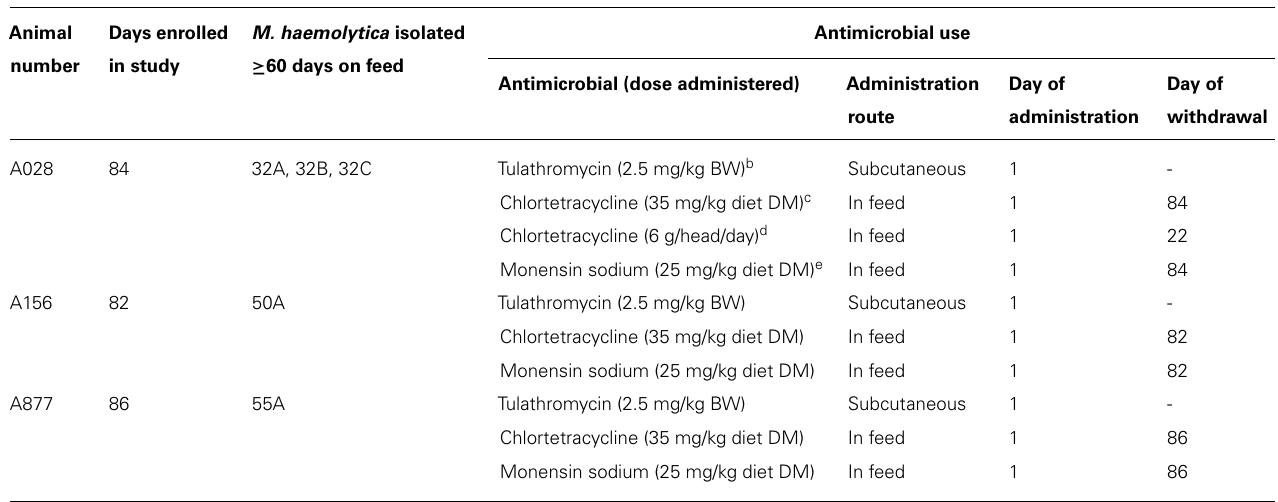
Cattle positive for M. haemolytica 403